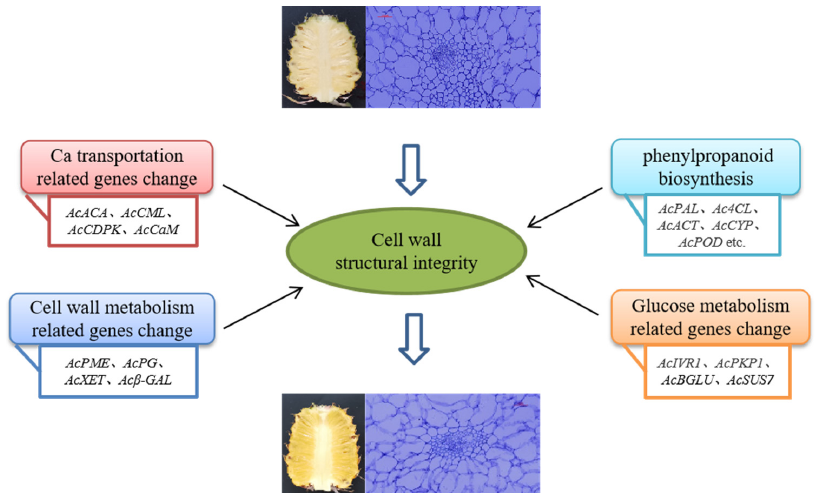
Figure 7. Speculated molecular mechanism of pineapple watercore.